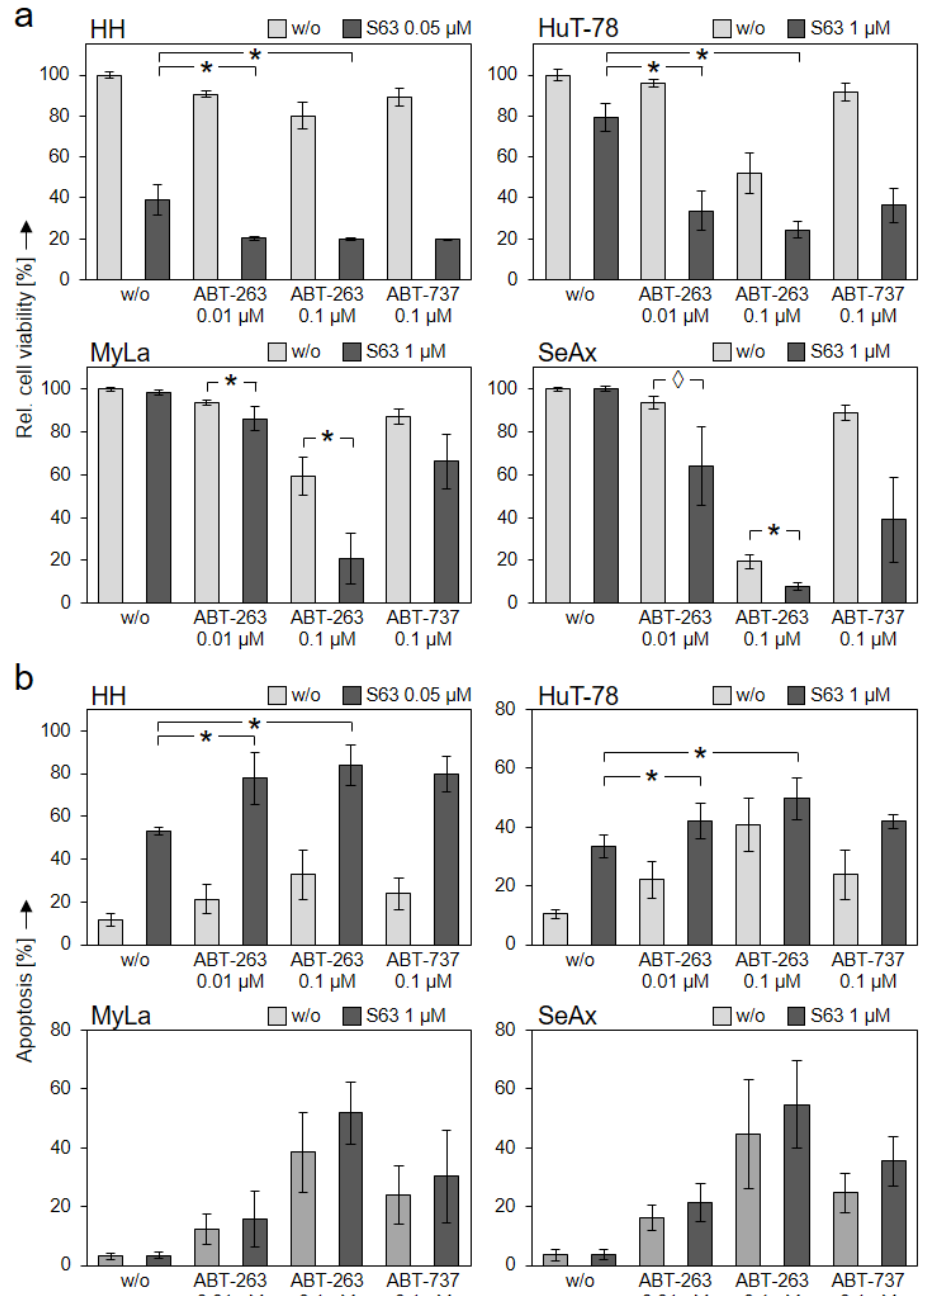
Figure 5. Further enhanced effects by antagonist combinations. CTCL cell lines were treated with S63845 (HH: 0.05 µM; HuT-78, MyLa, SeAx: 1 µM, dark bars), with ABT-263 (0.01 and 0.1 µM), with ABT-737 (0.1 µM) as well as with respective combinations. Cell viability (calcein staining, ( a )) and apoptotic rates (sub-G1 assay, ( b )) were determined after 48 h. Cell viability values were calculated in relation to non-treated controls, which were set to 100%; apoptotic rates correspond to percentages of sub-G1 cells (cells with fragmented DNA). Mean values of triplicates ± SD of representative experiments are shown. At least three independent experiments (each one with triplicate values) were performed for ABT-263 combinations, which showed highly comparable results. For ABT-737 combinations, two independent experiments (each one with triplicate values) revealed comparable results. Statistical significance (ABT-263) was calculated from the mean values of independent experiments, and is shown for cells treated with combinations vs. single treatments (*, p < 0.05). For some values, a statistical trend is also indicated ( ♦ , p <